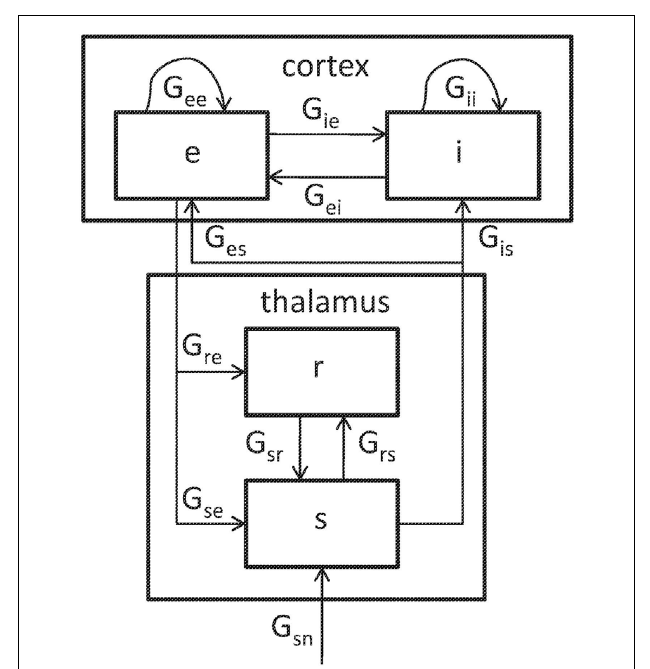
FIGURE 2 | Schematic representation of the model, including the following populations: e , cortical excitatory neurons; i , cortical inhibitory neurons; r , thalamic reticular nucleus; s , primary and secondary thalamic relay nuclei. In the linearized version of the model, each connection has a gain G ab ( a , b = e , i , r , s ).The relay nuclei receive input from the brainstem, indicated by the subscript n